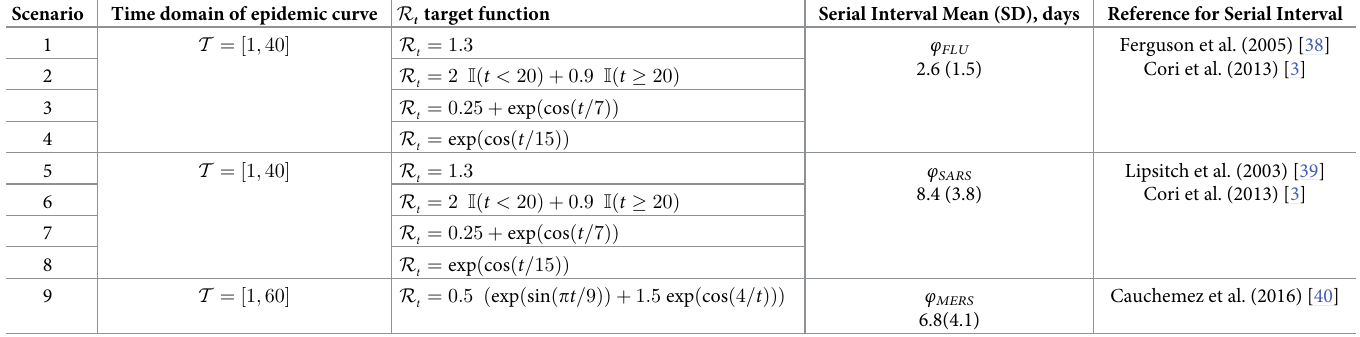
Table 1. Time domain of the epidemic curve, assumed functional form of the reproduction number, serial interval distribution and its associated source(s) in the lit- erature for the nine scenarios considered in the simulation study. Scenario Time domain of epidemic curve R target t